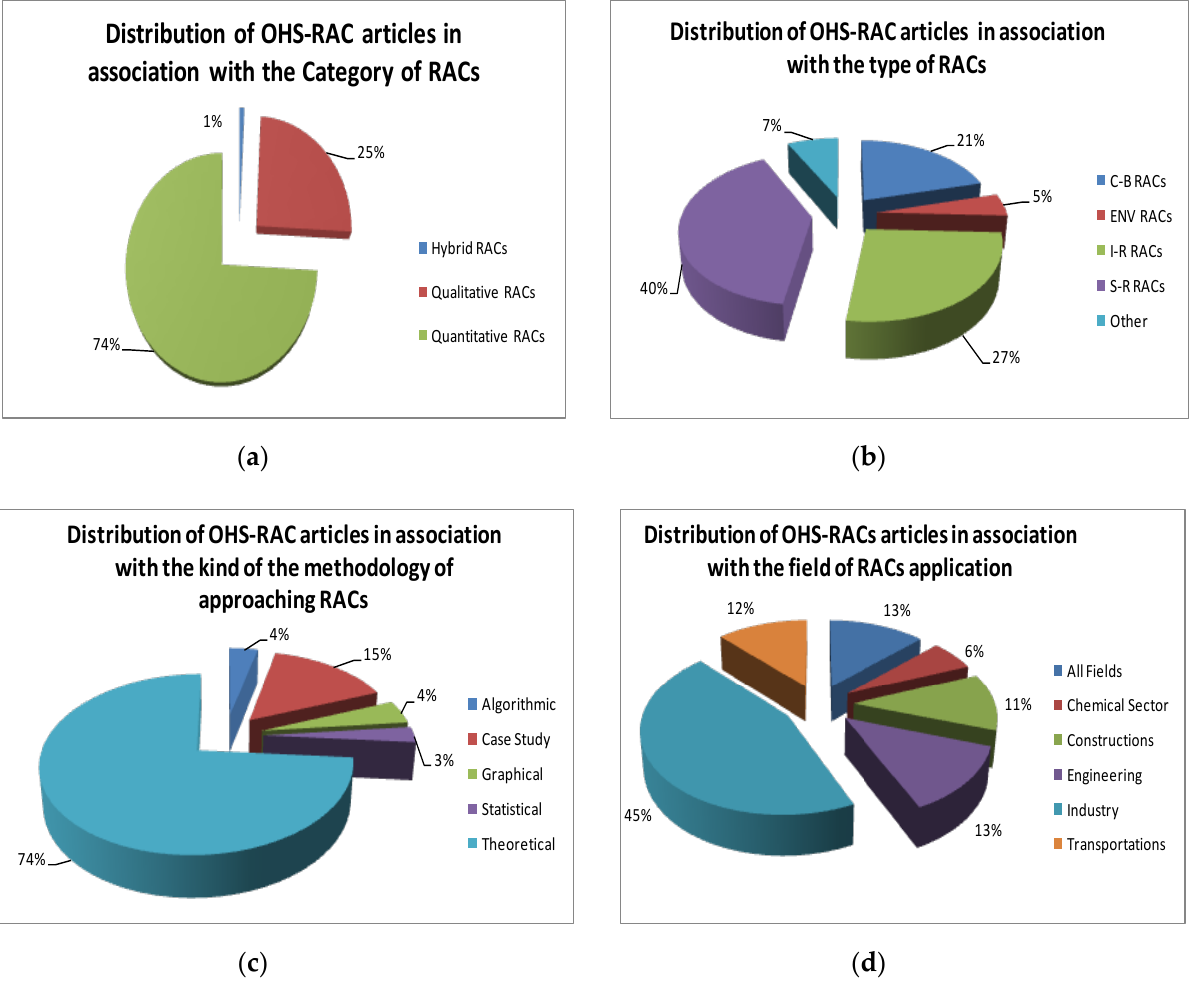
Figure 12. Thepiecharts display the distribution of OHSRAC articles published during the period of 2000–2019 in association with the ( a ) category of RACs, ( b ) type of RACs, ( c ) type of the methodology of approaching RACs, and ( d ) field of RAC application.